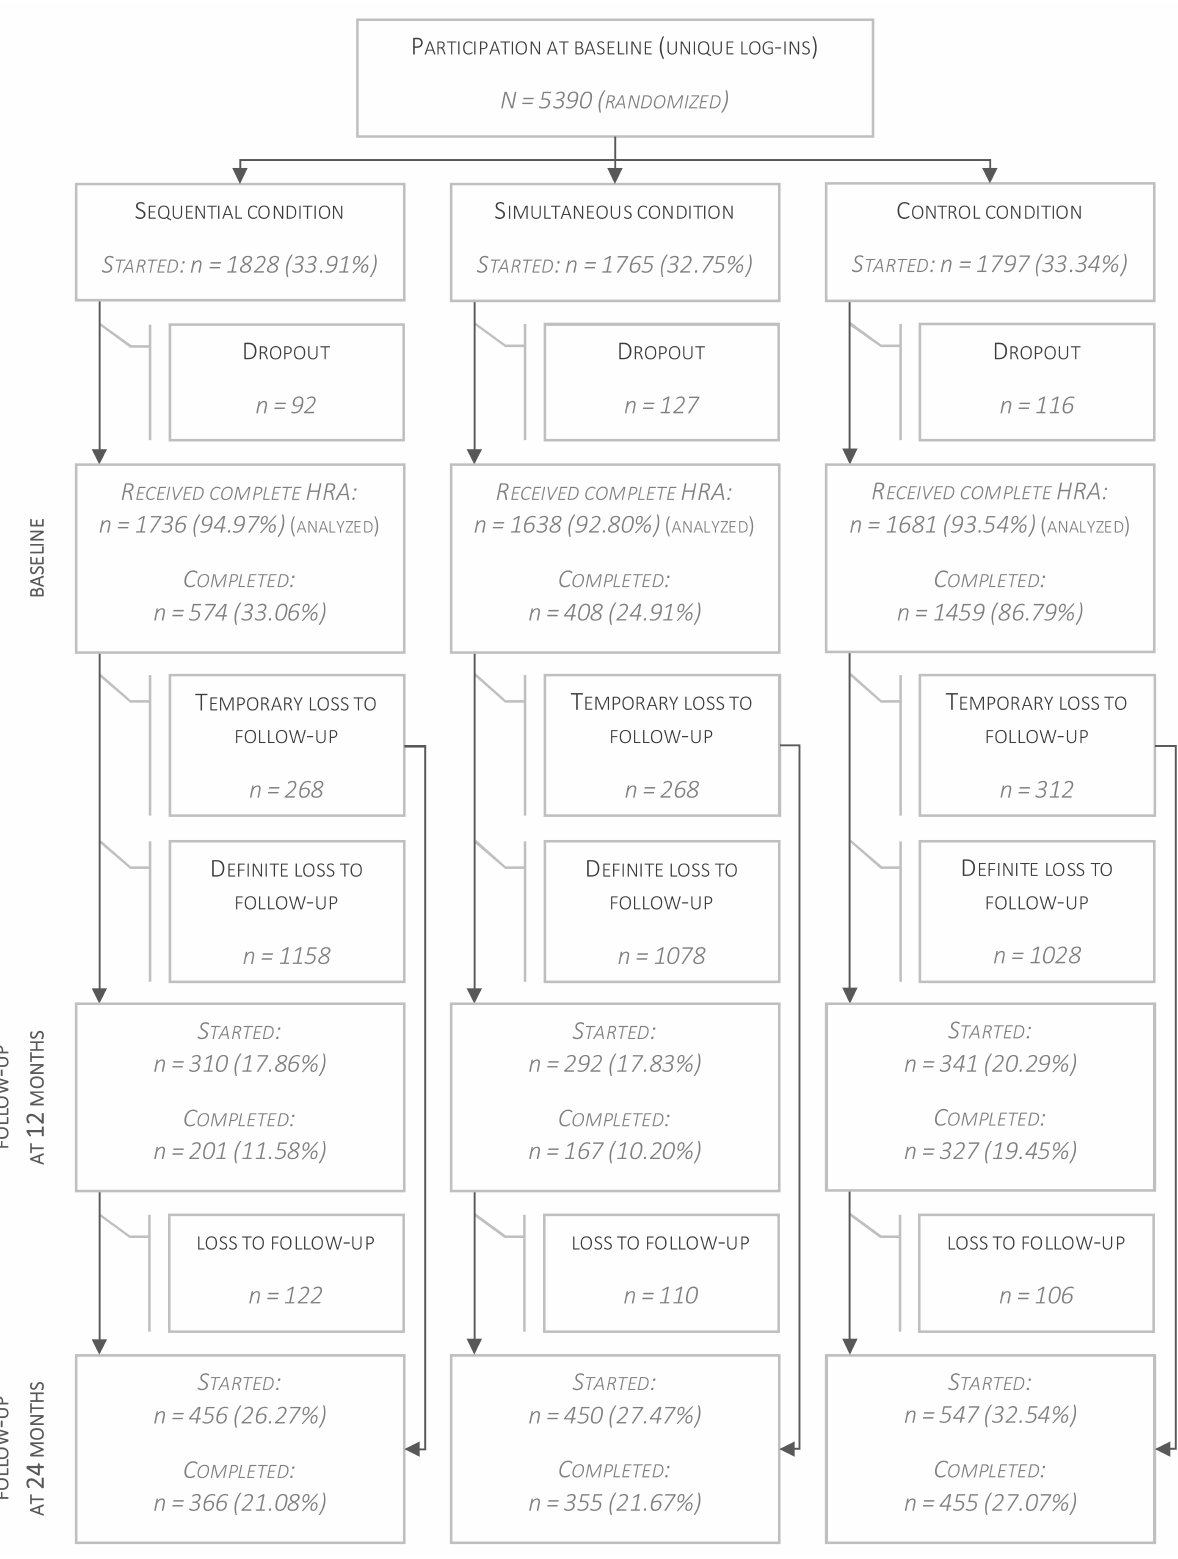
Figure 2. Flowchart of study participants. Completed: respondents who adhered to all study protocols; temporary loss to follow-up: respondents who did not complete the follow-up at 12 months, but did at 24 months; started: respondents who logged into intervention, but did not complete